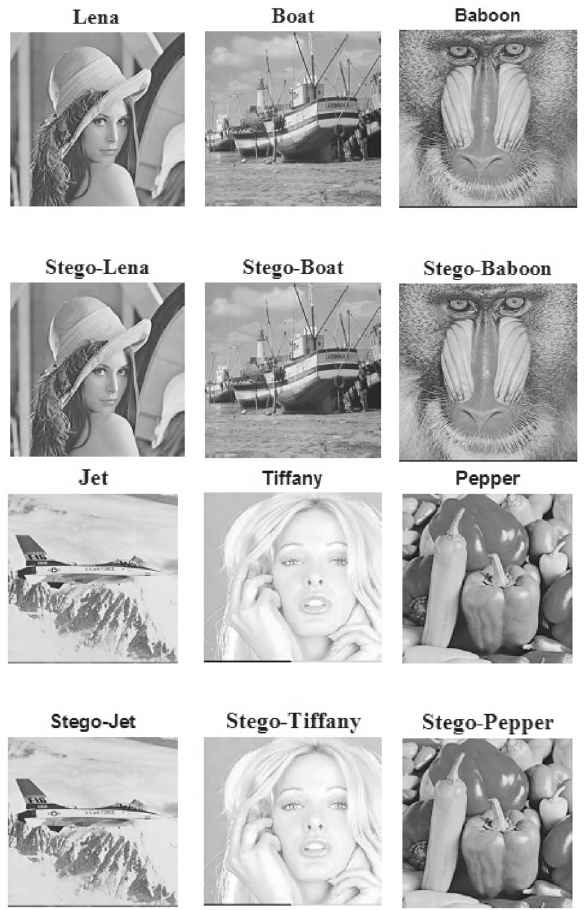
Fig.7 Visualrepresentationsamongthestegoimagesandcoverimages